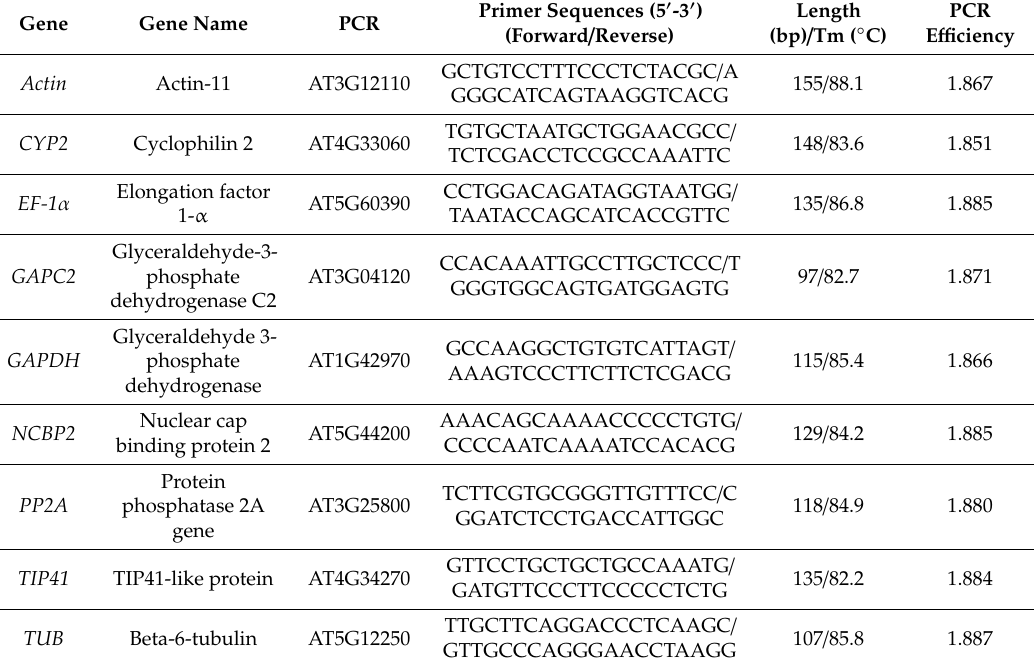
Table 1. Information of candidate reference genes and primers for RT-qPCR in Papaver somniferum